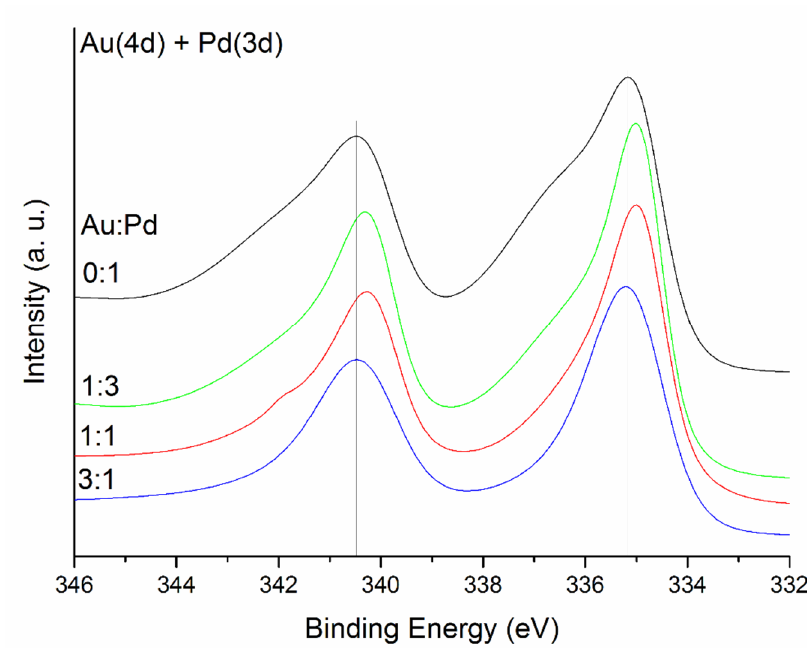
Figure 8. Au(4d) + Pd(3d) spectra for the series of Au x Pd y -TiO 2 catalysts.